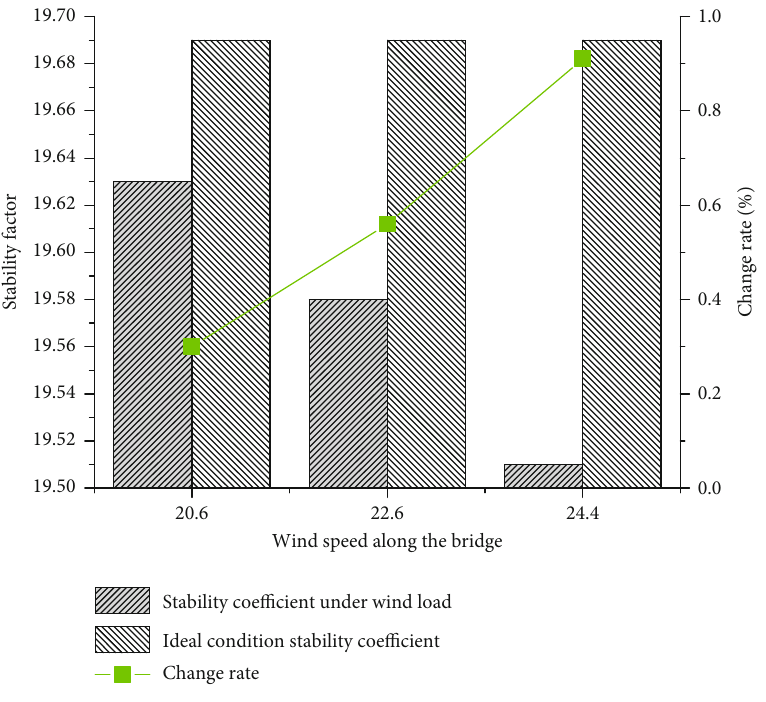
Figure 10: Comparison of the two geometric